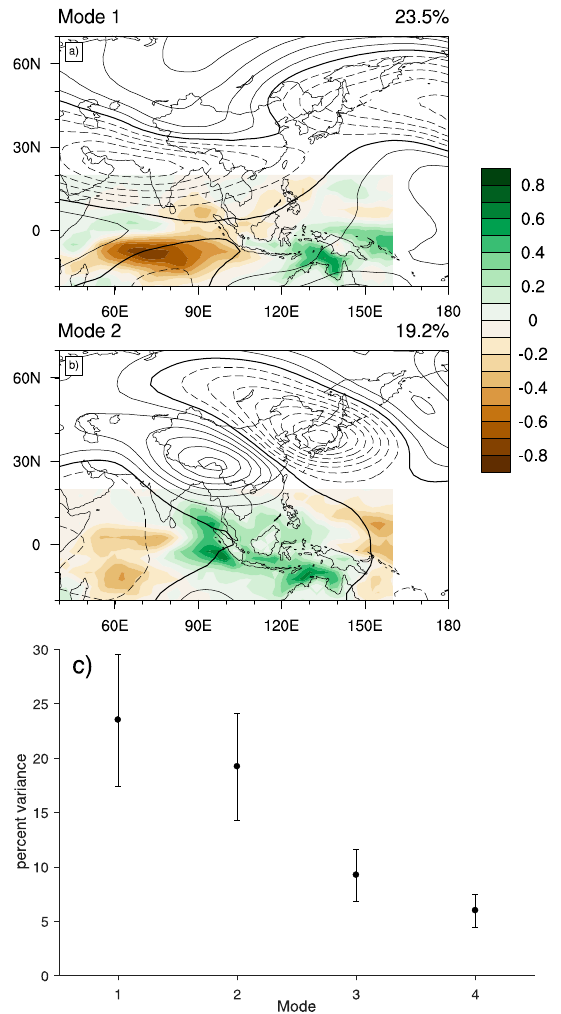
Figure 7. ( a , b ) Regressions of rainfall dipole (shading) and IWP-EA pattern (contours; int: 1 gpm) on the leading two PCs of rainfall dipole across the 30 members. The numbers at the top-right corner of each panel denote the percent variance explained by the EOF. ( c ) The error bars of percent variance for the first four EOFs [30].